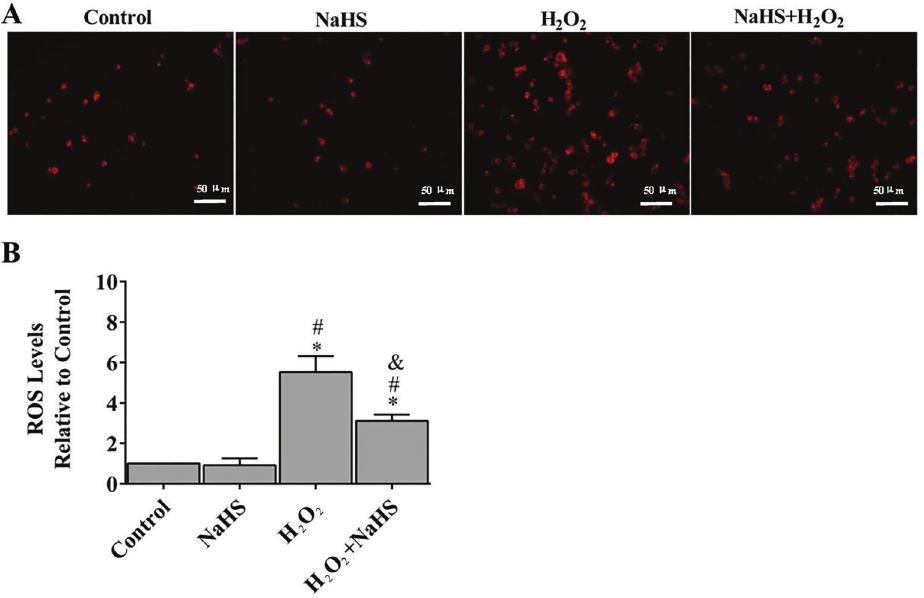
Figure 2. Hydrogen sul fi de (H 2 S) protected H9c2 cells against H 2 O 2 -induced oxidative stress ( A ). Intracellular superoxide anion production was detected with dihydroethidium and observed by fl uorescent microscopy ( B ). The fl uorescent signal was measured and quanti fi ed. Data are reported as means ± SE (n=6). *P o 0.01 vs control; # P o 0.01 vs NaHS; & P o 0.01 vs H 2 O 2 (ANOVA followed by Student-Newman-Keuls post hoc test). ROS: reactive oxygen